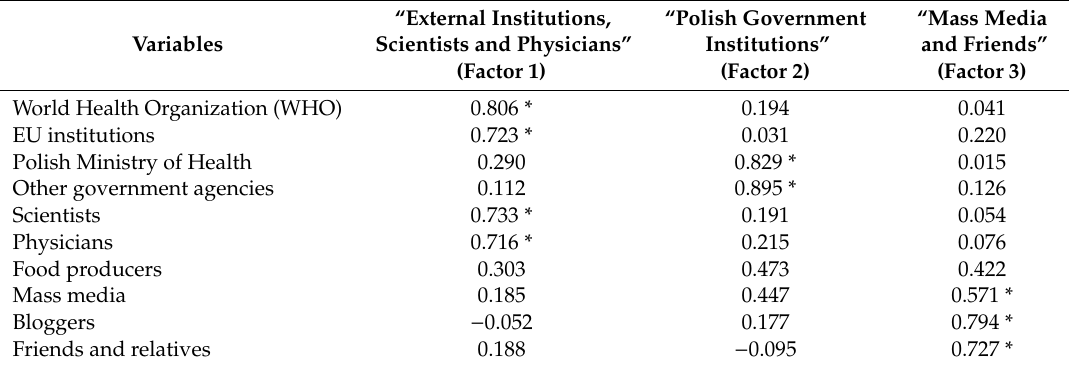
Table 1. Factor-loading